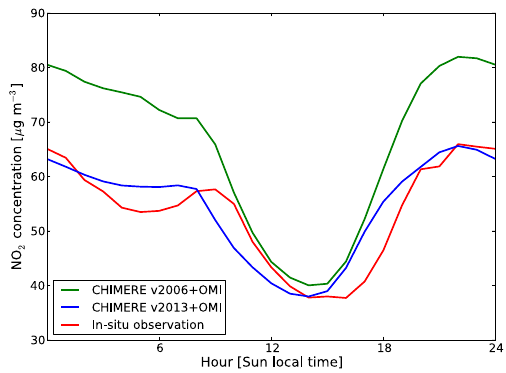
Figure 2. The diurnal cycle in Nanjing from January to August 2014 according to in situ observations, OMI-assimilated CHIMERE v2013 and CHIMERE